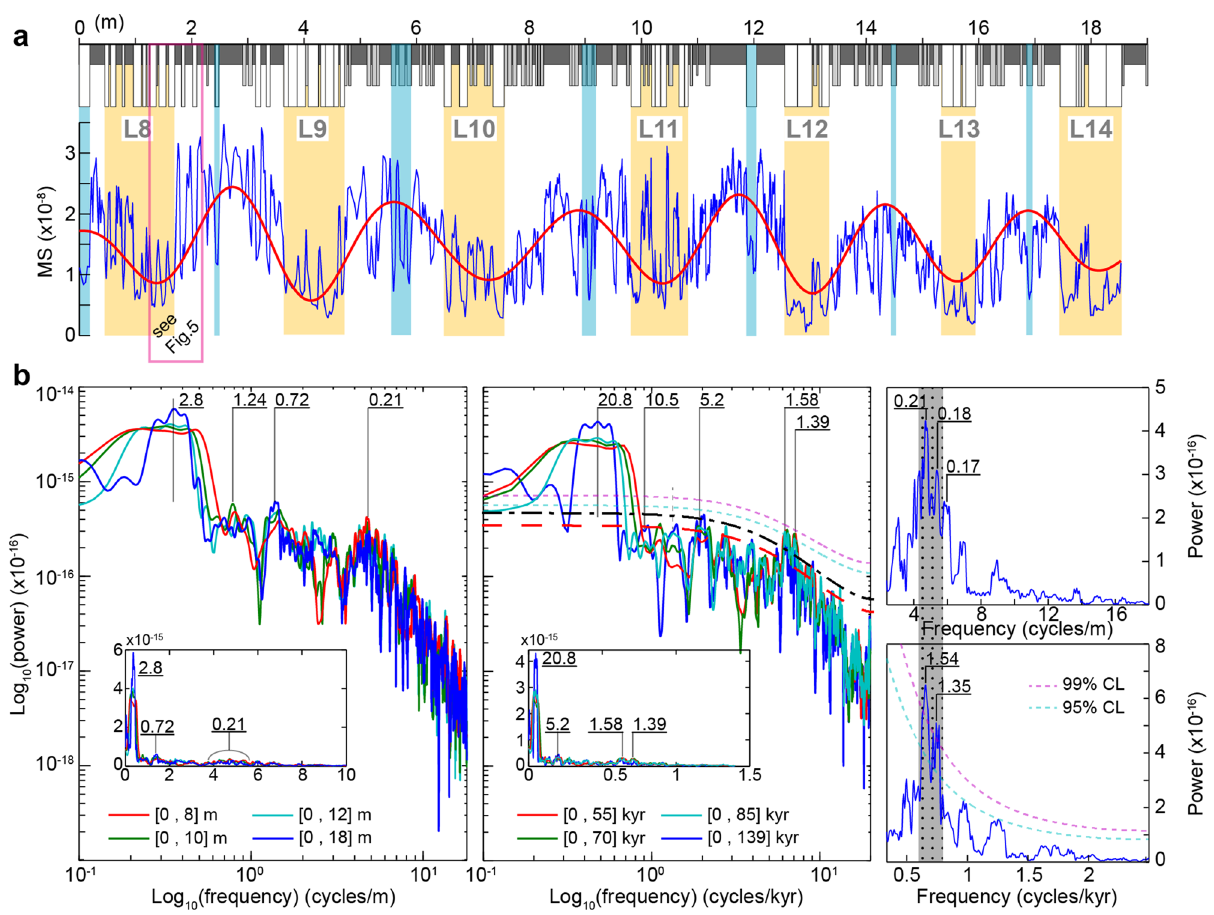
Figure 3. Lithostratigraphy and magnetic susceptibility (MS) data of the Lothari ammonite Subzone p.p. (Early Kimmeridgian, Late Jurassic, ~ 155 Ma) at La Cluse sedimentary succession (Subalpine Basin, SE France), and spectral analysis of MS data. (a) Lithostratigraphy and MS data, along with bandpass (2.8 m) filtering of the precession MS related cycles and basin-wide correlated precession cycle extremes L8 through L14 lithostratigraphic markers, which correspond to carbonate-rich intervals. For lithology, white: limestone, light grey: marly limestone, and dark grey: marls. (b) 2pi-MTM power spectra. Left panel: spectra per intervals in the stratigraphic (m) domain, middle panel: spectra per intervals in the time (kyr) domain (see “Methods” and Fig. 4), right panel: spectra of the interval 0–8 m and its equivalent in the time domain with a focus on the 1.5 kyr cycle band. Insets in the left and middle panels are the same spectra but in a linear scale and with tuncated Nyquist frequencies at 10 and 1.5 cycles/m (instead of 18 and 2.5 cycles/m respectively). Grey-dashed area in the right panel indicates the two close peaks at the beating frequencies of the 1.5 kyr cycle band that generate the half-precession periodicity. Remarkably, the interval from the base of the section till L10 shows a strong modulation of the 1.5 kyr cycle by the half precessional cycle (illustrated in Supplementary figures S5–S7). This is ultimately related to the high sedimentation rate within this interval that enhances the record of the 1.5 kyr cycle (see Fig.